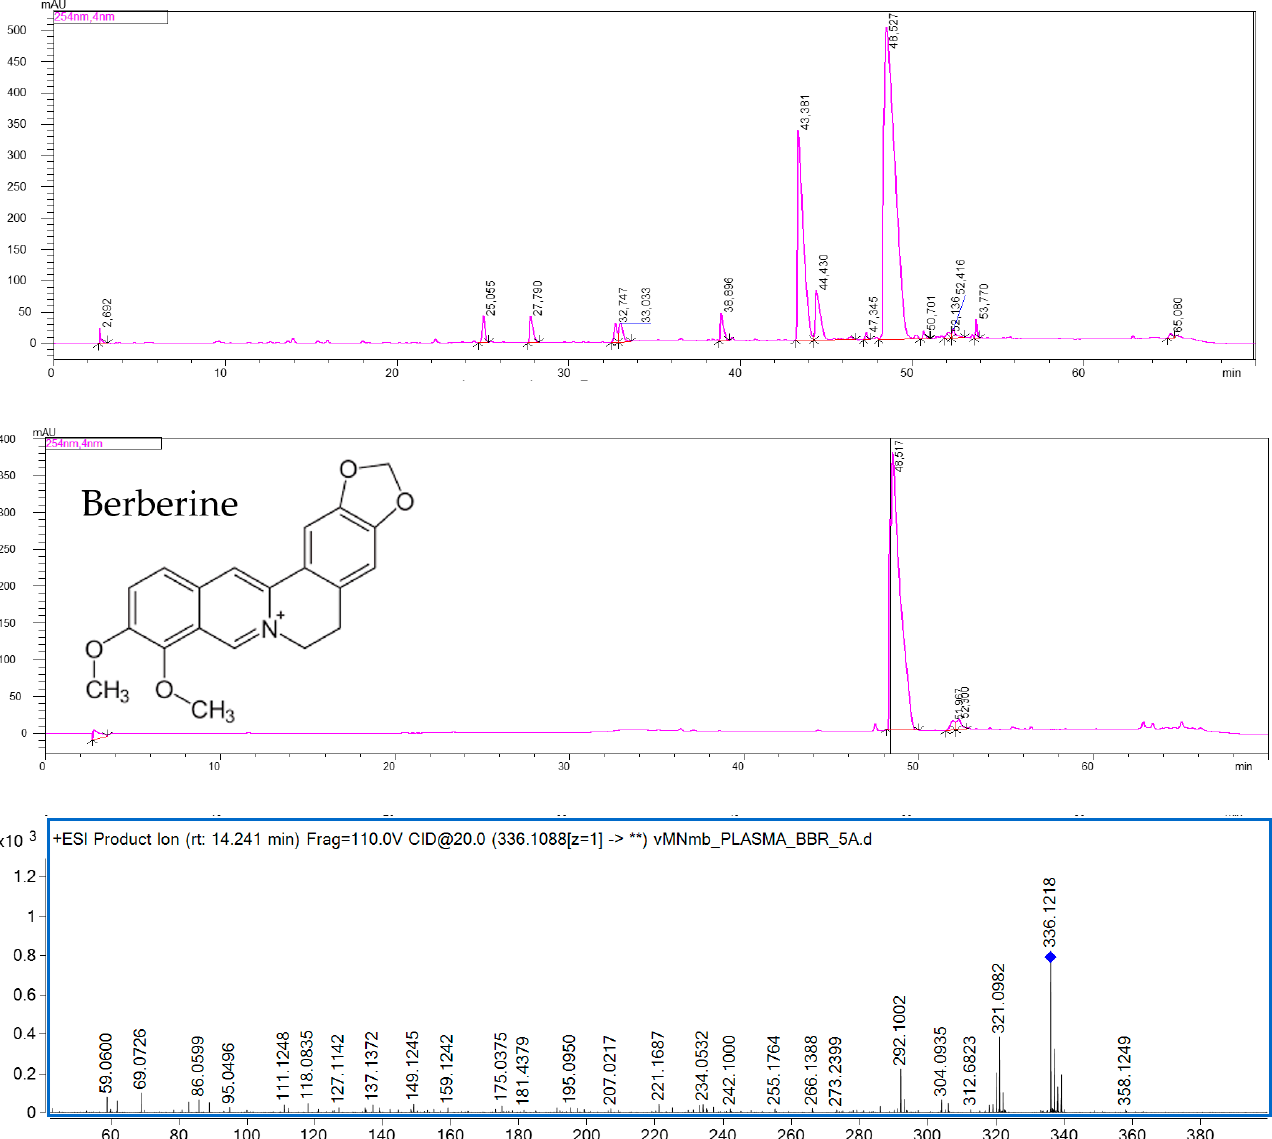
Figure 1. HPLC-UV chromatogram of the total extract from Berberis sibirica ( top ), the purity of the isolated berberine recorded at 254 nm ( middle ), and the fragmentation pattern (MS/MS chromatogram) of berberine ( bottom ).